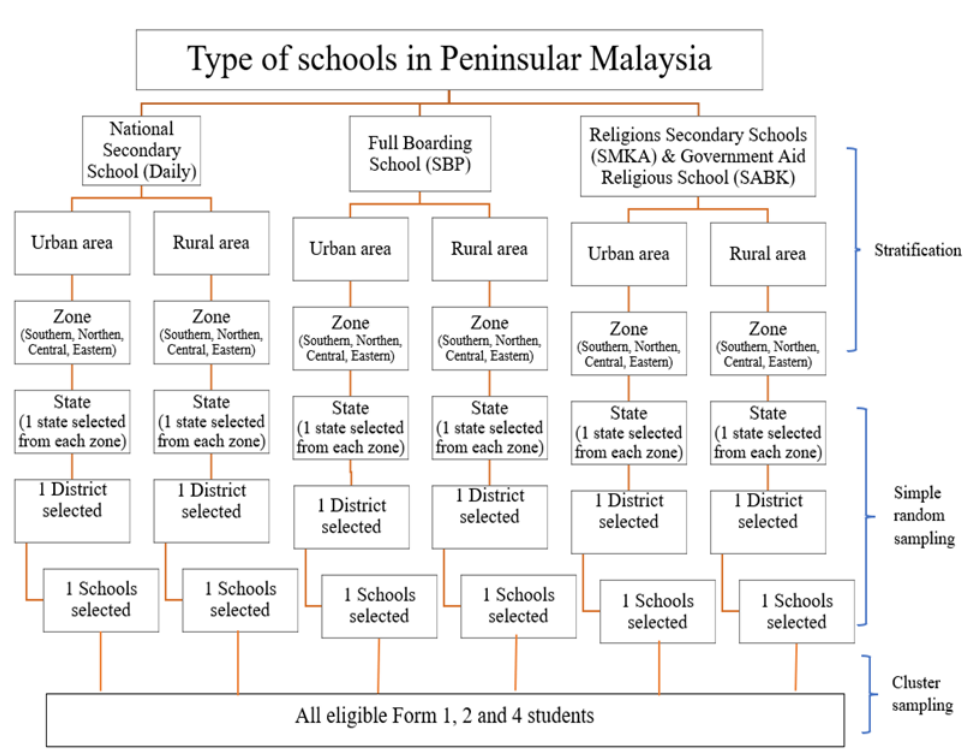
Figure 1. Sampling method and subject recruitment.